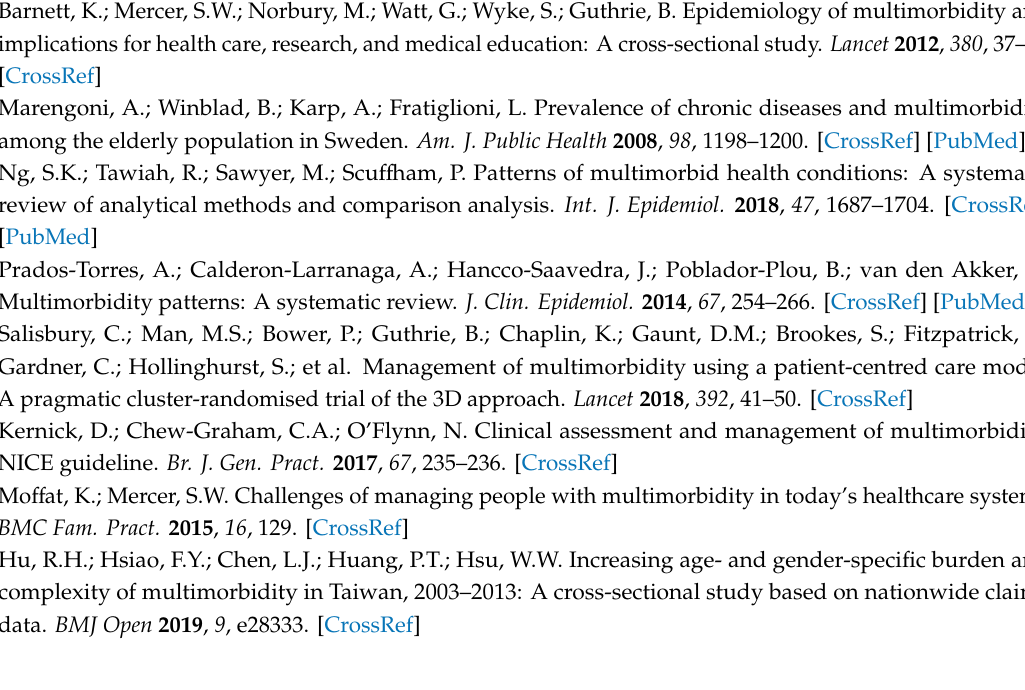
Table S1: International Statistical Classification of Diseases and Related Health Problems 10th Revision; Table S2: The proportions of ten most common two-disease combinations by age in males; Table S3: The proportions of ten most common two-disease combinations by age in females; Table S4: The proportions of ten most common two-disease combinations by health insurance